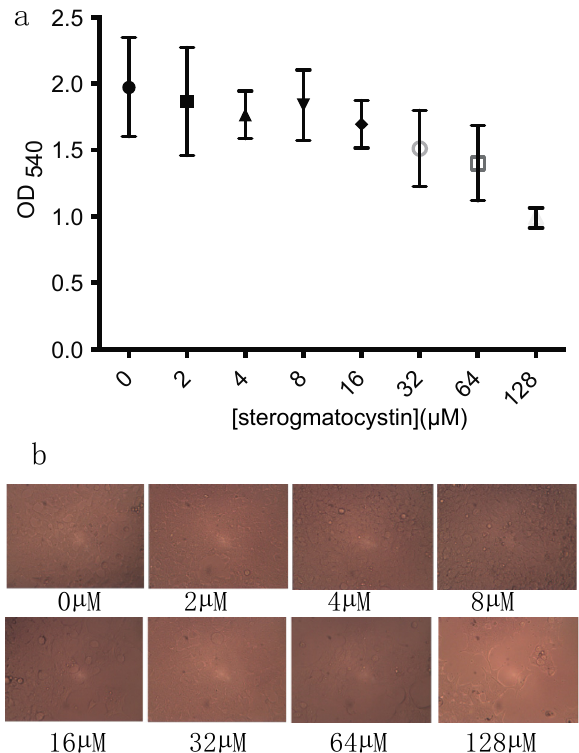
Figure 7. Cytotoxic effects of sterigmatocystin on human embryonic kidney 293 (HEK293) cell proliferation at varying concentrations were measured with MTT assays. ( a ) Compound did not show significant cytotoxicity to human embryonic kidney 293 cell line at a concentration of 64 µM (21.3 µg/mL) or lower; ( b ) density of living cells was significantly lower when Compound 1 reached 128 µM, compared to that of other concentrations ( p < 0.01). Test for each concentration was replicated three times. Data were analyzed using a t -test.